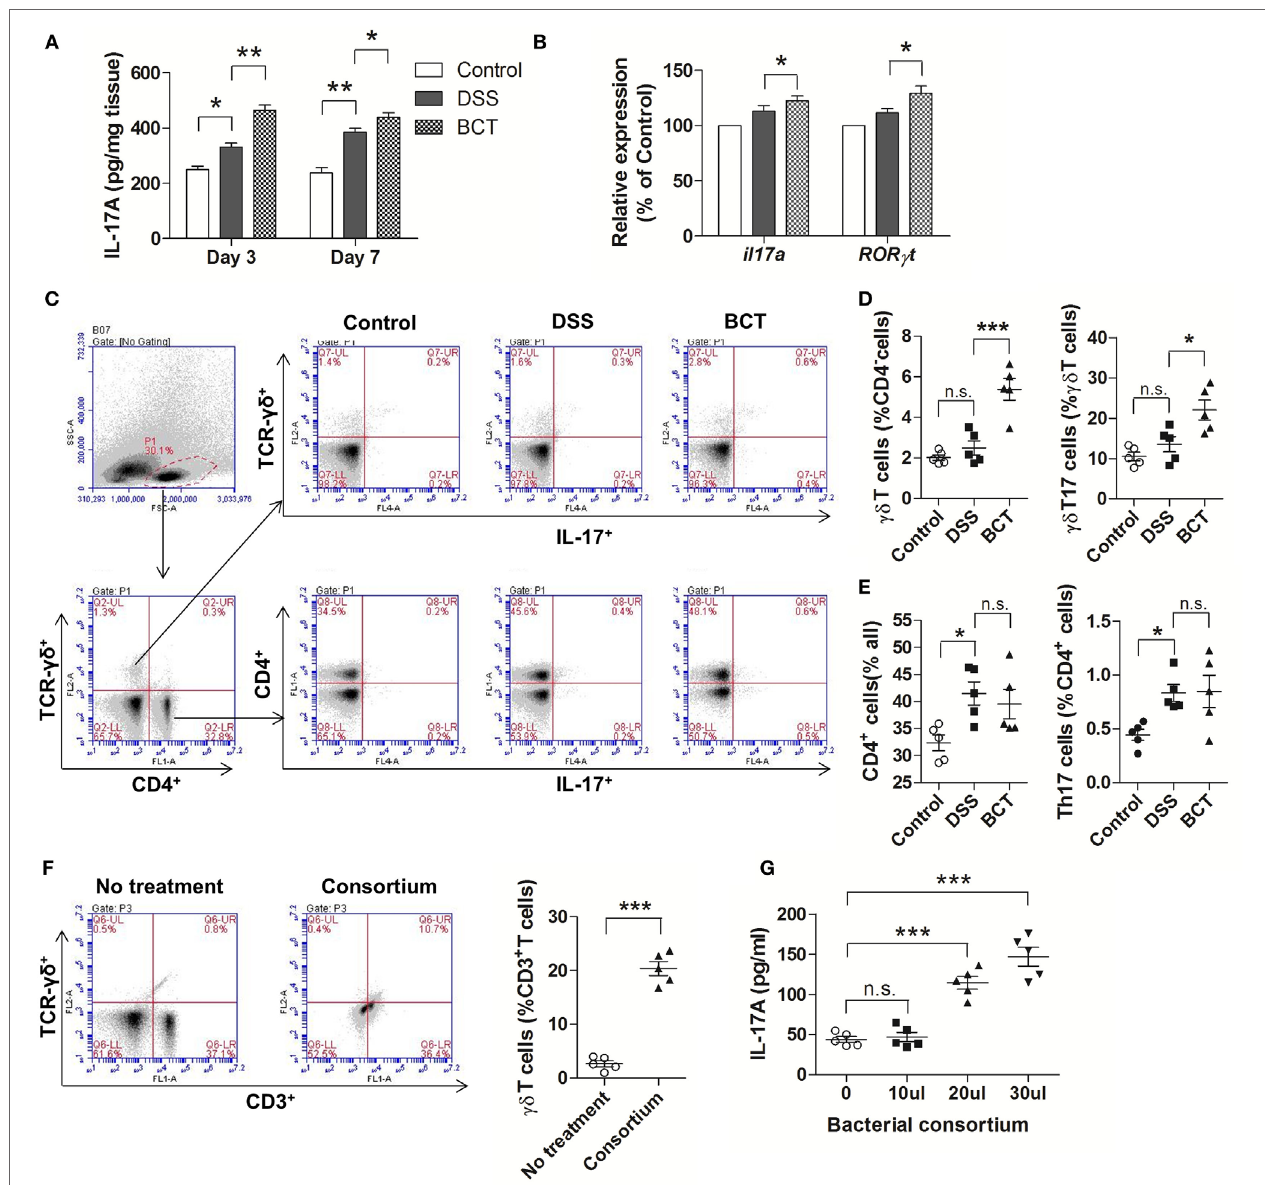
FigUre 3 | BCT upregulated IL-17 + γδ T cells in colonic lamina propria (cLP) of colitis mice. (a) The IL-17A concentration in each animal group was detected in supernatants of colonic tissue homogenates by ELISA. (B) The relative mRNA expression of il17a and ROR γ t in colon tissues of mice detected by qPCR. (c) Representative flow cytometry plots of CD4 + T cells identified using side scatter and forward scatter plots (left panel) and TCR- γδ + expression. And the representative flow cytometry plots of γδ T17 cells (TCR- γδ + IL-17A + ) (upper panel) and Th17 cells (CD4 + IL-17A + ) (bottom panel). (D) Percentage of γδ T cells and γδ T17 cells in γδ T cells from cLP of different mice. (e) Percentage of CD4 + T cells and the percentage of Th17 cells in cLP of mice from different groups. (F) Representative flow cytometry plots and evaluation of the percentage of γδ T cells among cLP cells treated or un-treated with 30 µl of the bacterial consortium in vitro . (g) IL-17A concentration in supernatant from cLP cells treated or un-treated with different volumes of the bacterial consortium in vitro detected by ELISA. All values are mean ± SEM ( n = 5). Statistical analysis of the quantitative multiple group comparisons was performed using the one-way analysis of variance followed by Tukey’s test, * p < 0.05, *** p < 0.001, n.s., not